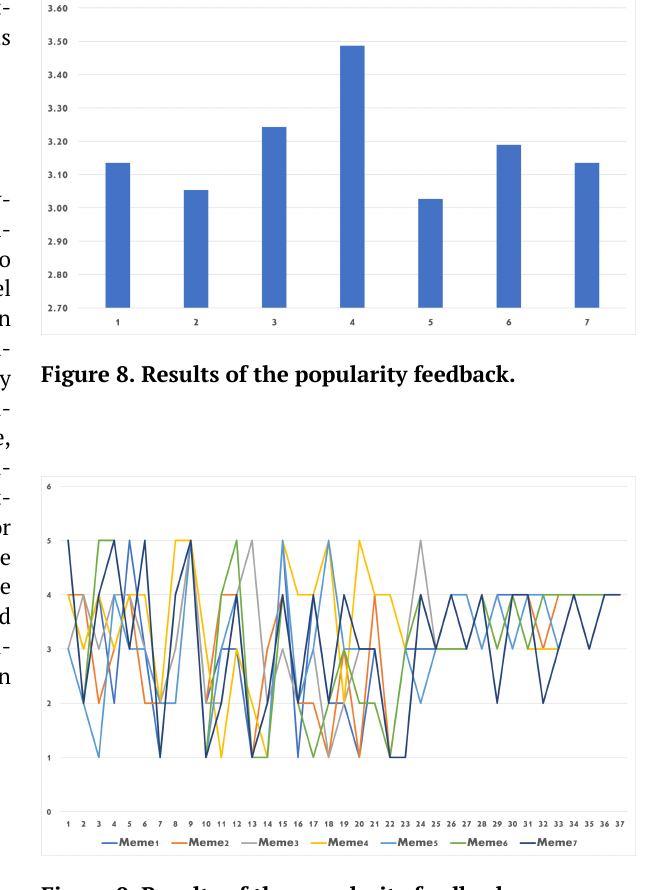
Figure 9. Results of the popularity